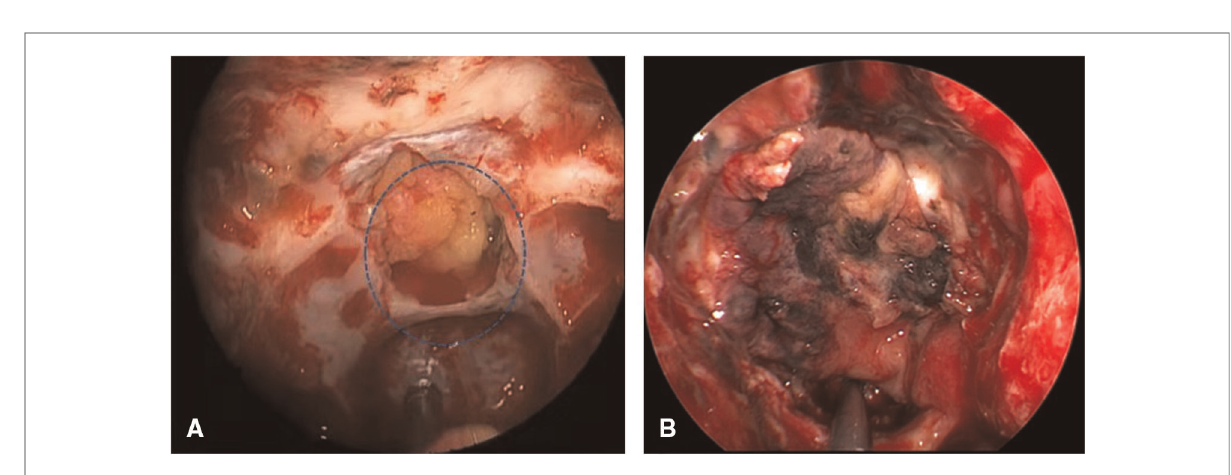
FIGURE 5 ( A ) Insuf fi cient embedded fat ( circle ). ( B ) VP-NSF inactivation. VP-NSF, vascularized pedicle nasoseptal fl